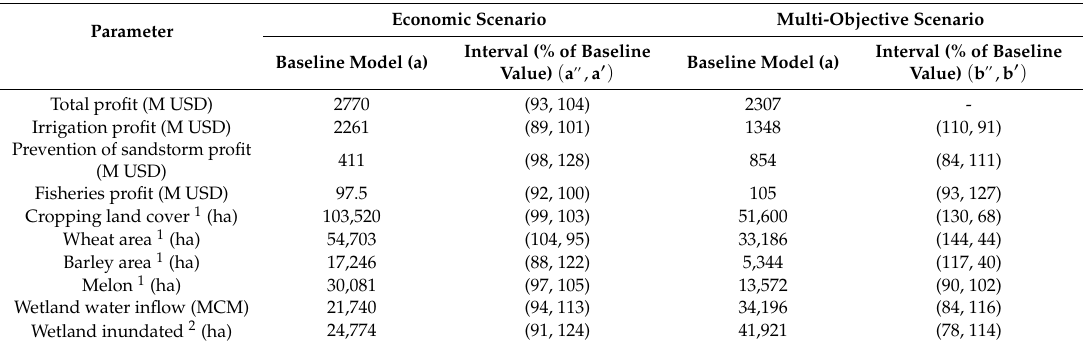
Table 6. Sensitivity Analyses, Various